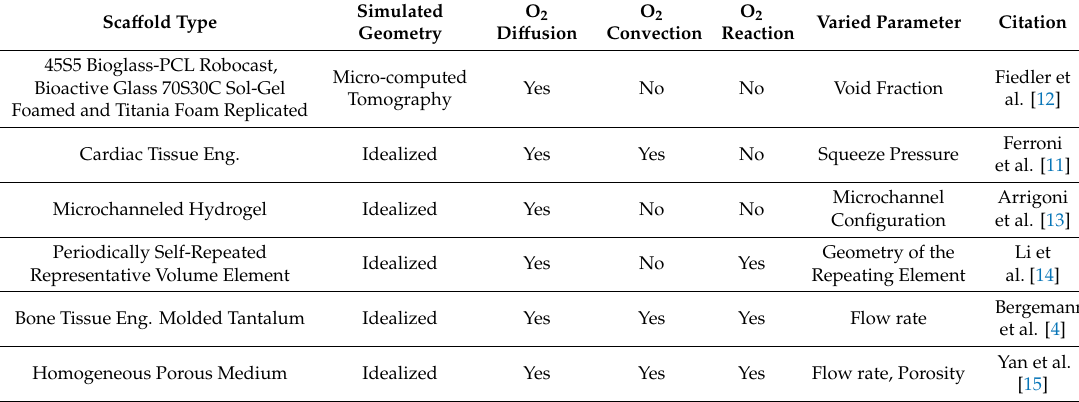
Table 1. Literature overview of O 2 simulations in tissue engineering sca ff olds, shows that image-based simulation of convection with di ff usion and reaction has not yet been